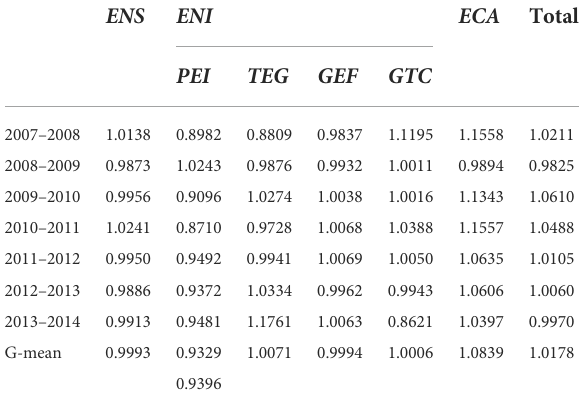
TABLE 4 Changes of sample countries ’ carbon emissions and its decomposition, 2007 –